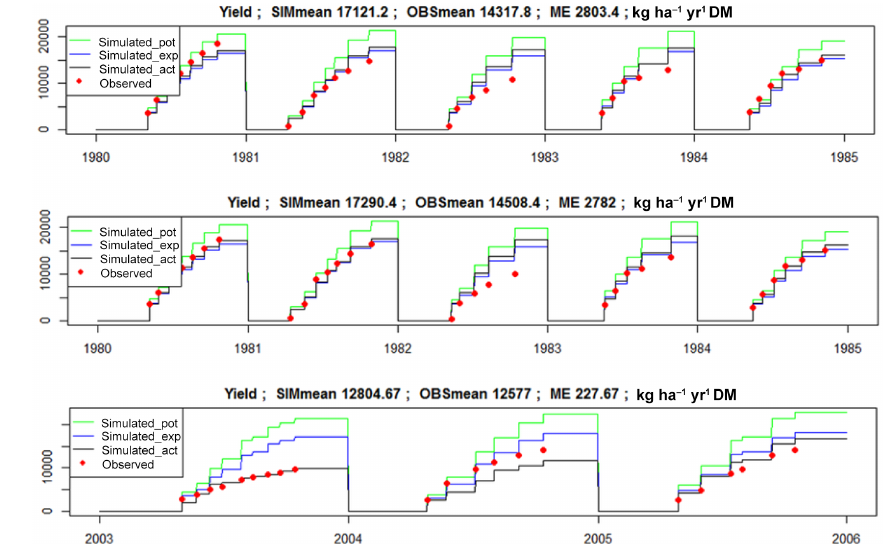
Figure 5. Results of simulated and observed yields of grassland: Ruurlo16 (upper panel), Ruurlo48 (middle panel), and Zegveld03 (lower panel). The green lines correspond with simulated potential yield; blue with the simulated exploitable yield; black with the simulated actual yield; and the red dots indicate the observed yield of a grassland cut. SIMmean, OBSmean and ME are annual mean values for simulated actual yield, observed yield and the difference (maximum error ME).